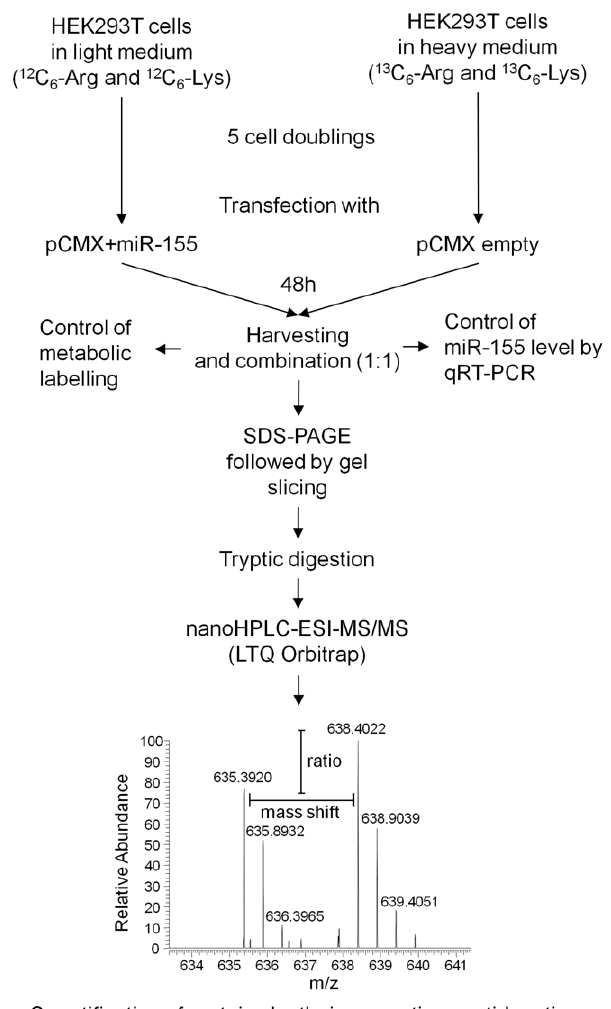
Figure 1. Experimental setup of SILAC quantification.